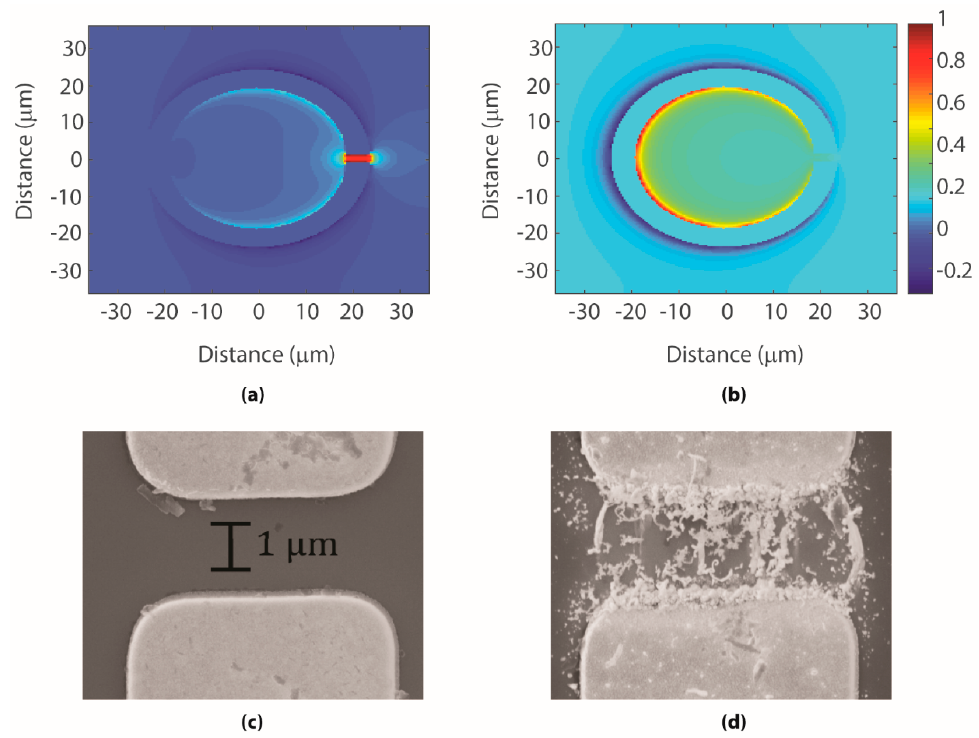
Figure 1. Numerical simulations of the normalized peak ( a ) electric field and ( b ) magnetic field distributions in a split ring resonator excited by an incident THz signal. Electric fields are confined to the capacitive gap region, while magnetic fields are confined near the areas of high current density in the resonator. ( c , d ) Before and after pictures showing mass transfer of gold patterning in a metamaterial antenna structure. Mass transfer is induced by the highly confined resonant fields in the 1 µ m thick gap region. Reproduced from